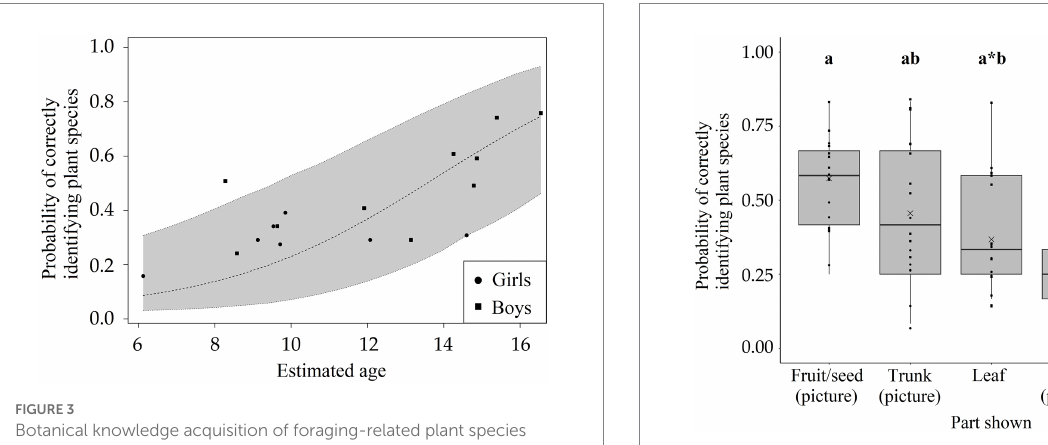
The effect of age, gender, and part of the foraging-related plant species shown on the probability of correctly identifying the species was examined ( N = 1,020; model B know ). Shown are the estimates together with the standard errors (SE), lower and upper 95% confidence interval (CI lower and CI upper ), likelihood ratio tests results ( χ 2 , df, p -value), as well as the statistical significance of the individual parts shown with picture bark as reference ( p -value), and the minimum and maximum estimates based on the model stability analyses (min and max). Significant results ( p < 0.05) are indicated in bold. Model B know : Full-null model comparison: χ 2 = 28.284, df = 6, p < 0.001; marginal R 2 : 0.164, conditional R 2 : 0.685. a Z-transformed; mean ± SD of original variable age was 11.646 ± 3.054. b The variables gender and those of part shown were dummy coded with girl and picture bark as reference, respectively.